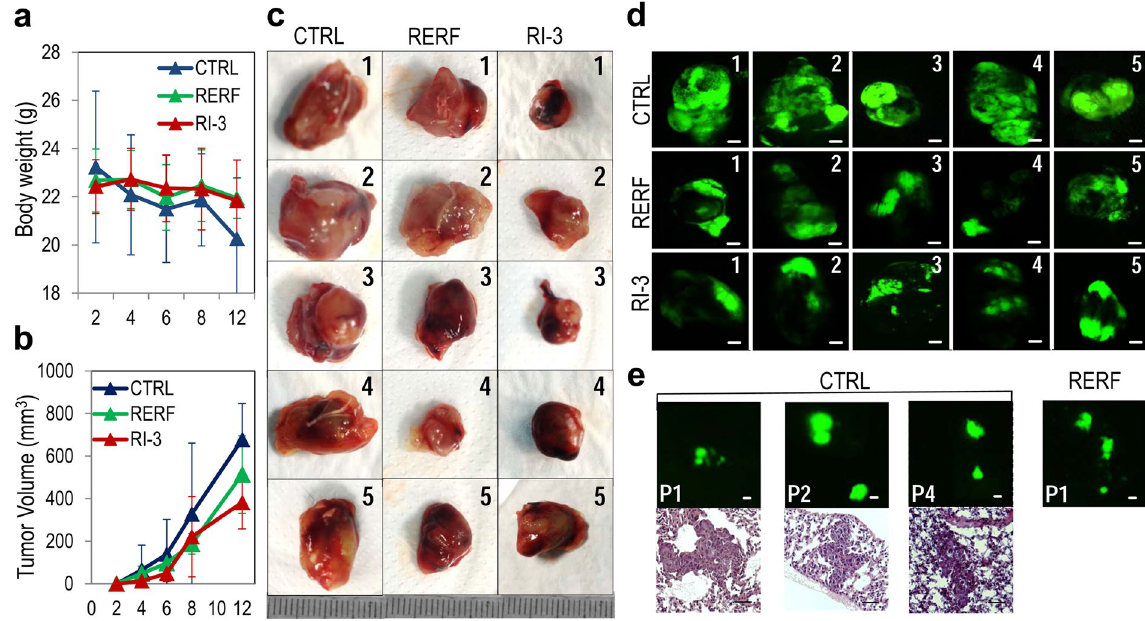
Figure 10. RI-3 exerts anti-metastatic effects in vivo . Fifteen six-eight weeks old, Foxn1nu/nu female nude mice of 22 to 25 g, received an injection of GFP-Sarc cells into the right flank as a single-cell suspension (1 × 10 6 cells in 100 µ l of sterile PBS, 96% viability). Ten animals received i.p. injection of 6 mg/kg peptide RI-3 (5 mice) or peptide RERF (5 mice) every 24 hr and five received injections of vehicle only (CTRL). After 12 days, mice were sacrificed ( a ) Body weight measured every 2 days. ( b ) Tumor volumes measured by caliper every 2 days using the formula ½ × (width) 2 × length (mm). ( c ) Excised tumors from vehicle-(CTRL), RERF- and RI-3-treated mice. ( d ) Fluorescent primary excised tumors visible with MacroFluo fluorescence stereomicroscope. Scale bar: 2 mm. ( e ) Fluorescent positive nodules in excised lungs and H&E stained sections (Scale bar: 50 µ